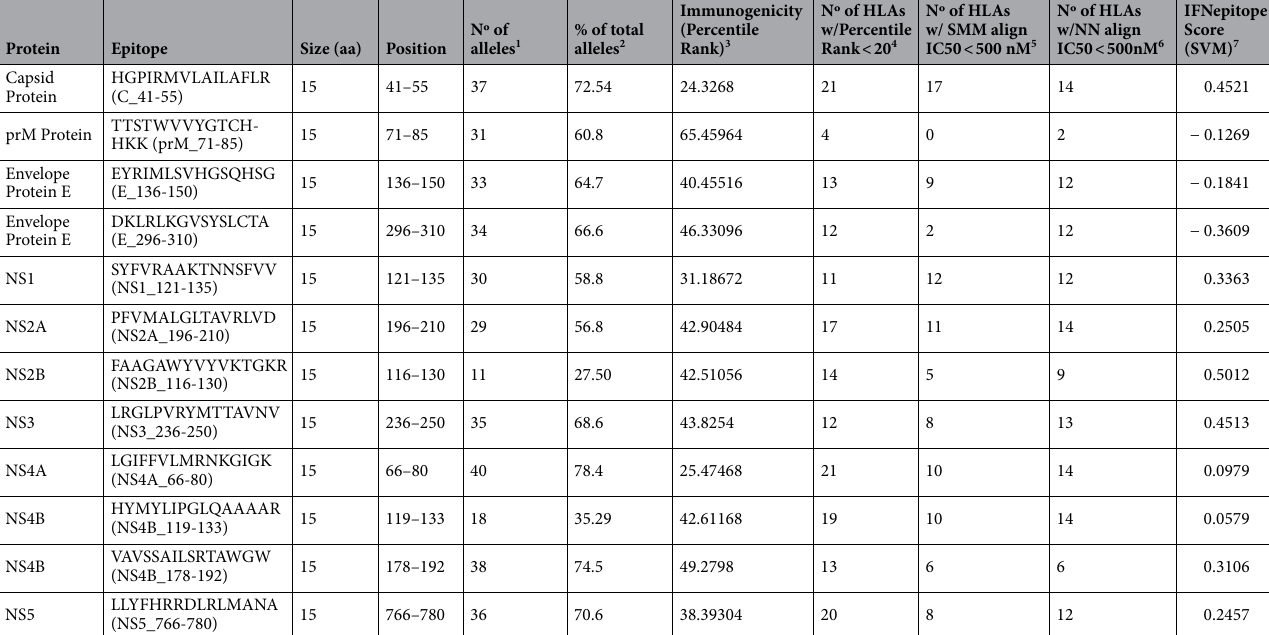
Table 2. Zika virus CD4 peptide selection based on multiparameters using immunoinformatics tools. 1— Total number of HLA-II covered by the peptide as predicted by Propred MHC-II Binding Peptide Predicition Server. All 51 alleles were selected. The threshold was set up as 1%. 2—Percentage of HLA-II molecules identified as binders in relation to the total number of HLA-II available. 3—Immunogenicity percentile rank obtained with http:// tools. iedb. org/ CD4ep iscore/. Lower numbers are considered immunogenic (lower than 66). 4—Number of HLA that presented percentile rank lower than 20 (high affinity). 5—Number of HLA that presented SMM IC50 lower than 500 nM (high affinity). 6—Number of HLA that presented NN IC50 lower than 500 nM (high affinity). 7—IFN-γ induction score. Positive values indicate IFN-γ induction.